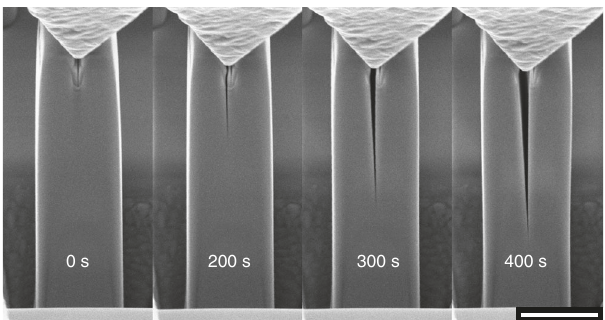
Fig. 2 Slow stable crack growth. A sequence of frames extracted from the video recorded during one of the in situ tests. The wedge tip at the top can be seen moving down as the test advances, causing the opening of the DCB; the crack slowly grows for a few microns over a total time of more than 350 s until the tip displacement is stopped and held in